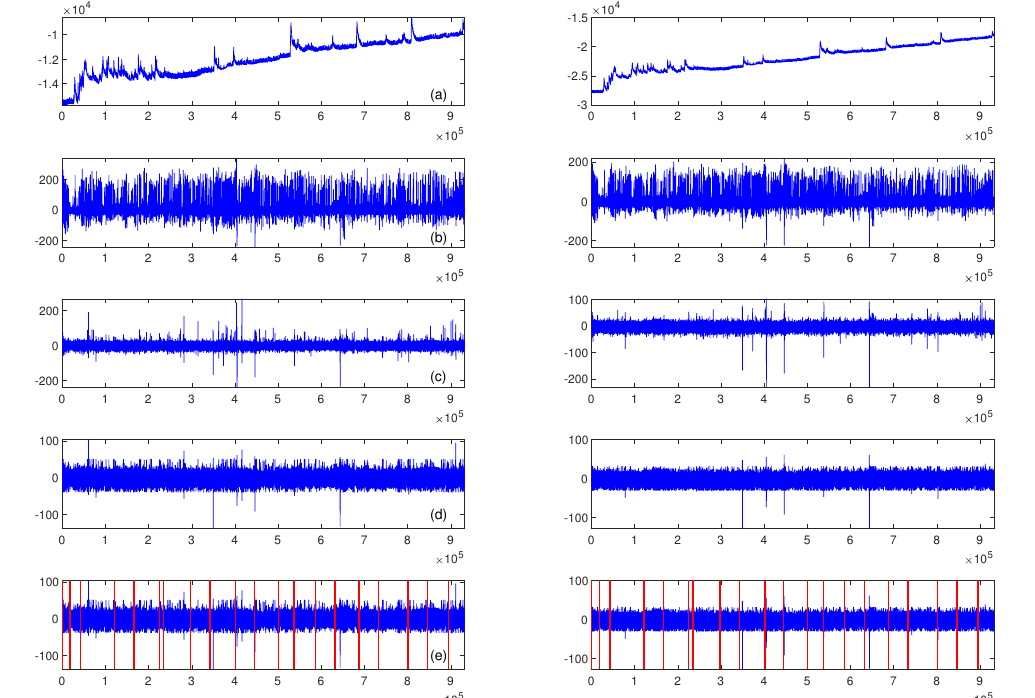
Figure 3. The preprocessing procedure via signal recorded from subject S1 performing Task B; left column of plots—Fp1 channel, right column of plots—Fp2 channel; ( a ) raw signal, ( b ) signal after temporal filtering, ( c ) signal after spatial filtering, ( d ) signal after median filtering, ( e ) signal divided into epochs, each vertical line corresponds to the epoch onset (the epochs’ order is presented in Figure